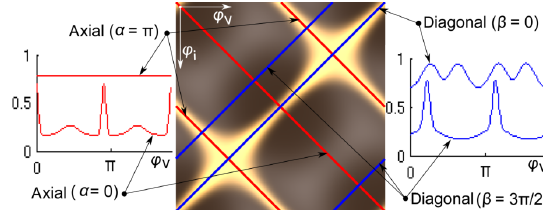
A schema of axial (red, perpendicular to anisotropic highlights) and diagonal (blue, perpendicular to specular highlights) slices placed in the 2D subspace (fixed both θ i = 60 ◦ and θ v = 60 ◦ ) and their function values. Note that the subspace is